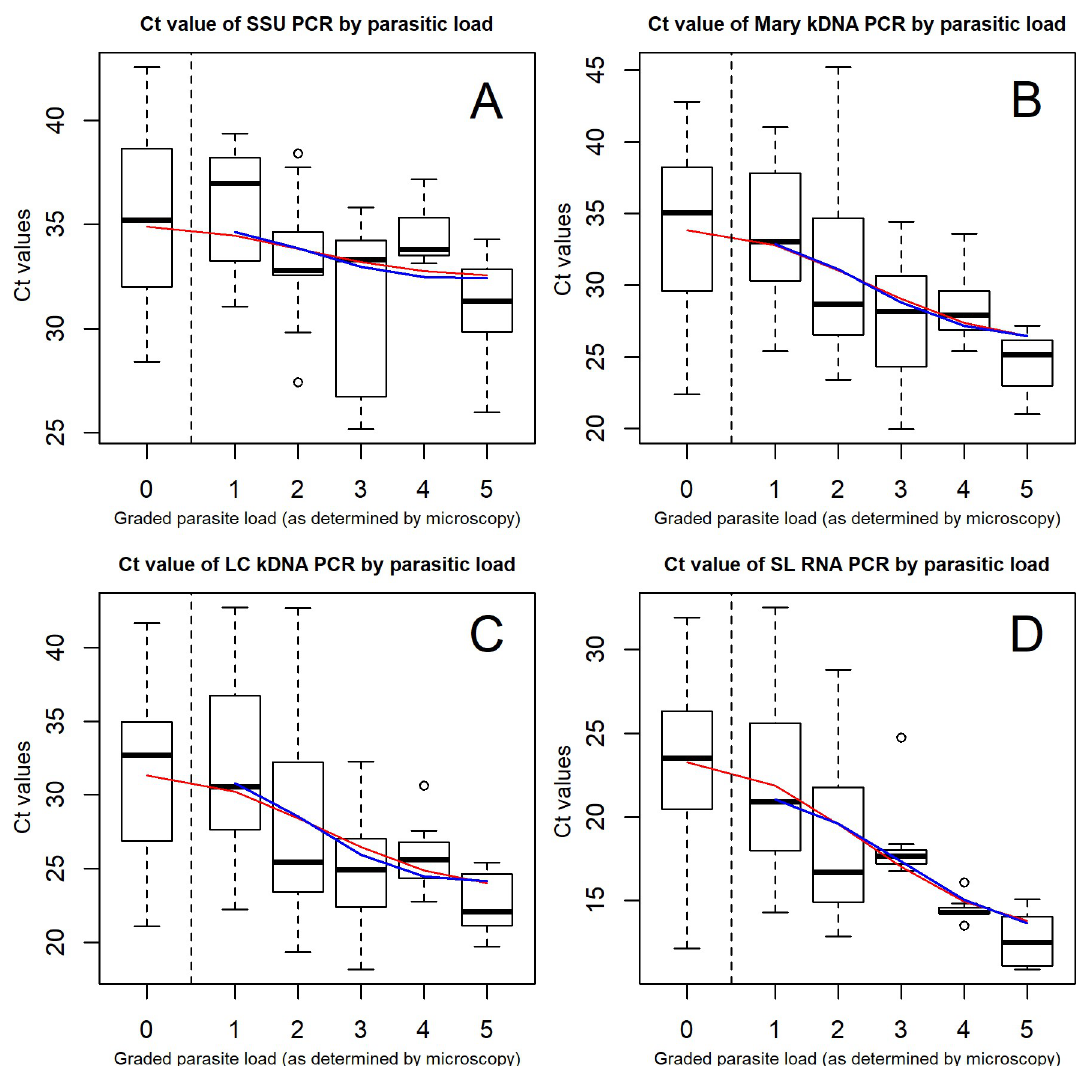
Fig 3. Boxplot for comparison of Ct-values with microscopy parasite load. The thick horizontal lines in the box represent the median; the bottom and top line of the box are the 25th and 75th percentile respectively. The red fitted line shows the trend of Ct- values of samples which were identified as positive by PCRs, including those negative by microscopy. The blue line shows the trend of Ct-values of the PCR by parasite load as of +1 in